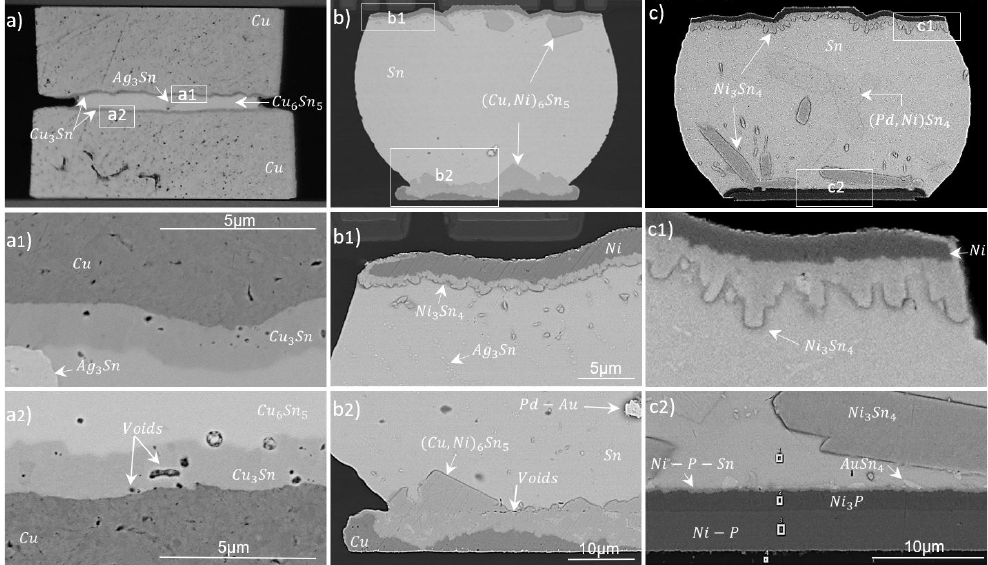
Figure 12. Solder-joint cross-sections of a bonded Cu120-SAC-Cu120 (double pillar) sample with a 40µm solder ball ( a ); Cu80-C4ROC ( b ) and ENIG80-C4ROC samples with 100µm C4 solder bump ( c ). Magnified views of upper and lower UBM interfaces for three samples are shown as ( a1 ), ( b1 ) and ( c1 ); and ( a2 ), ( b2 ) and ( c2 ), respectively.